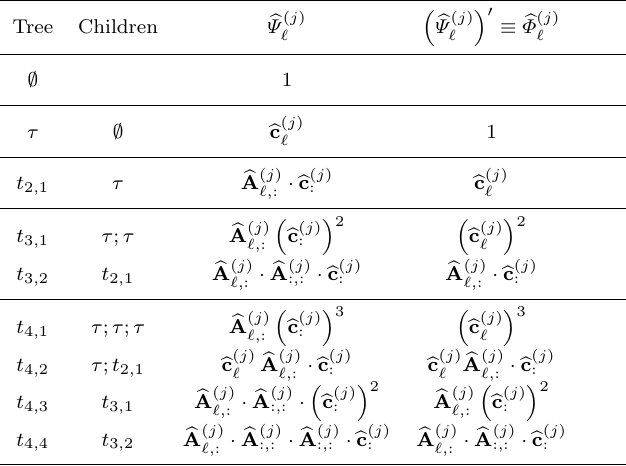
Table 2. The B-series of the numerical solutions together with their derivatives. The tree notation follows the one in [15, Table 2.2, page 148].